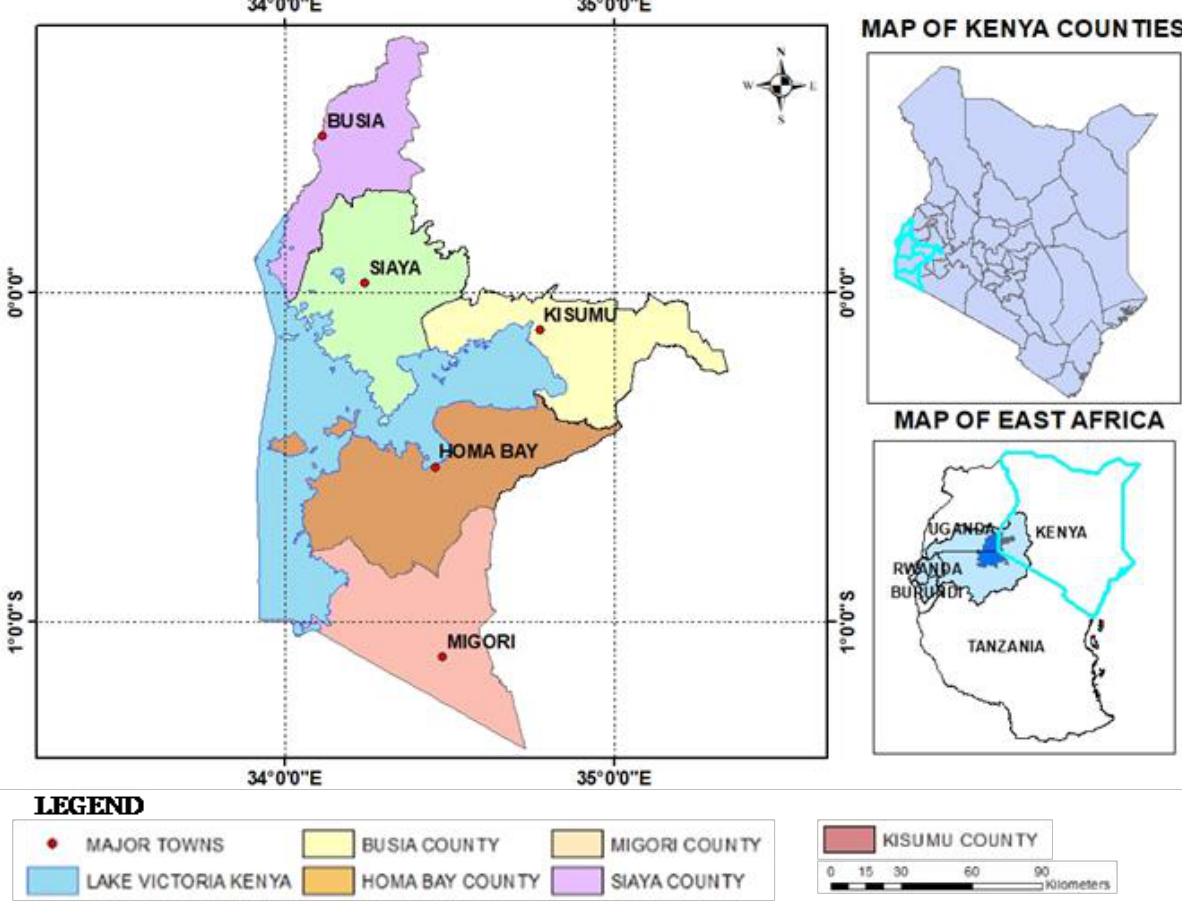
Fig. 1. Map of the Kenyan Lake Victoria